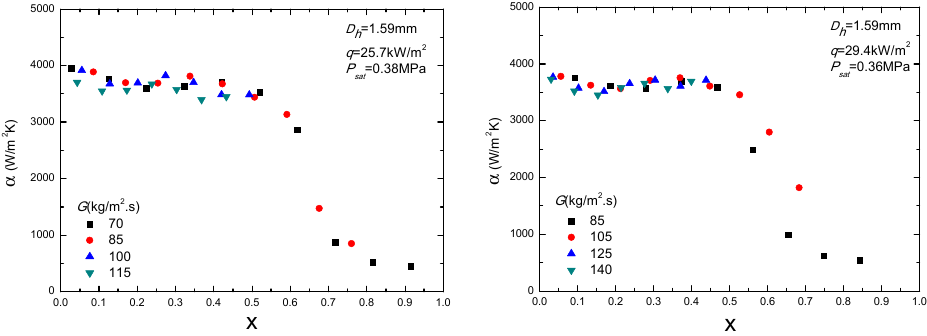
Figure 4. Effect of mass flux on the heat transfer coefficient.